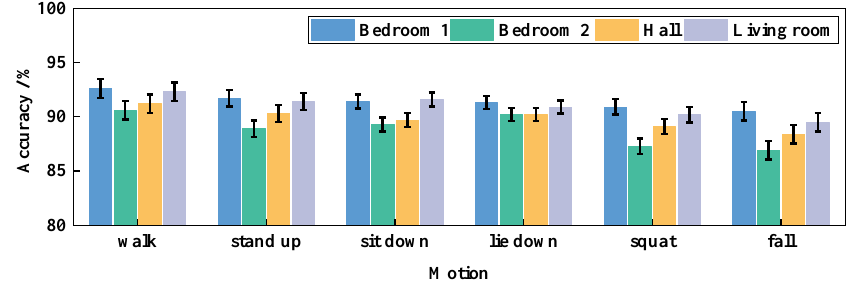
Figure 11. Through-wall performance comparison.